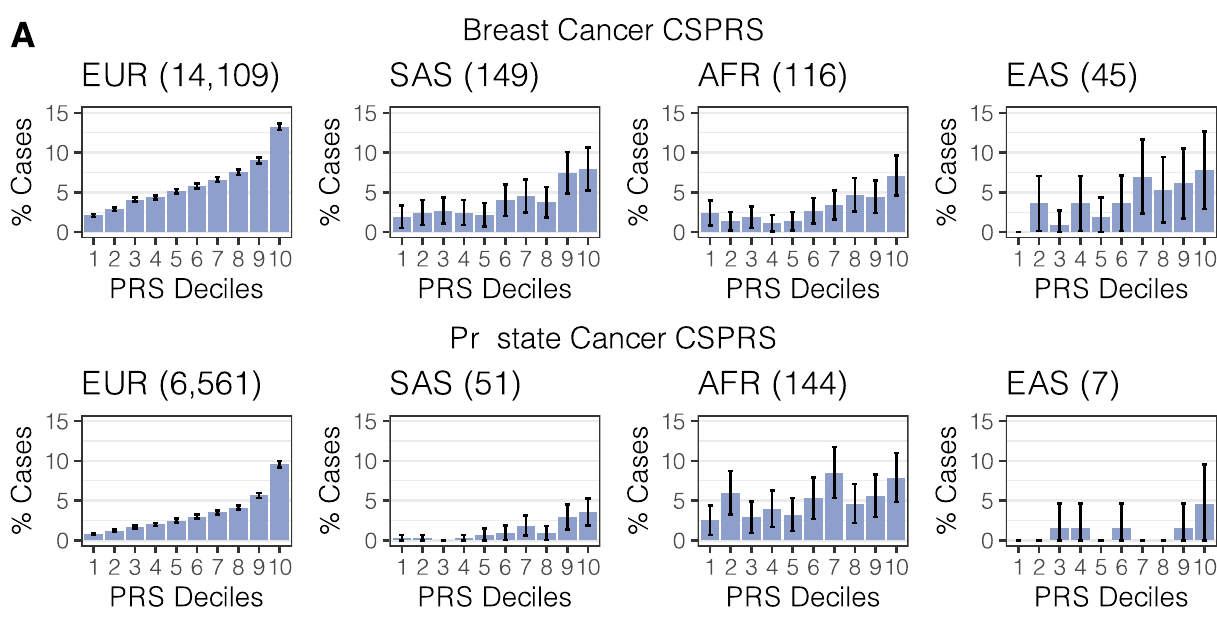
Fig 2. Observed case proportion across CSPRS (PRS-CS-based PRS) risk deciles. Proportions of breast cancer cases (A) and prostate cancer cases (B) stratified by ancestry groups are shown. Total case counts per ancestry group are given in parentheses. Underlying sample counts and corresponding Cochran-Armitage Test for Trend P-values are reported in S3 and S4 Tables.